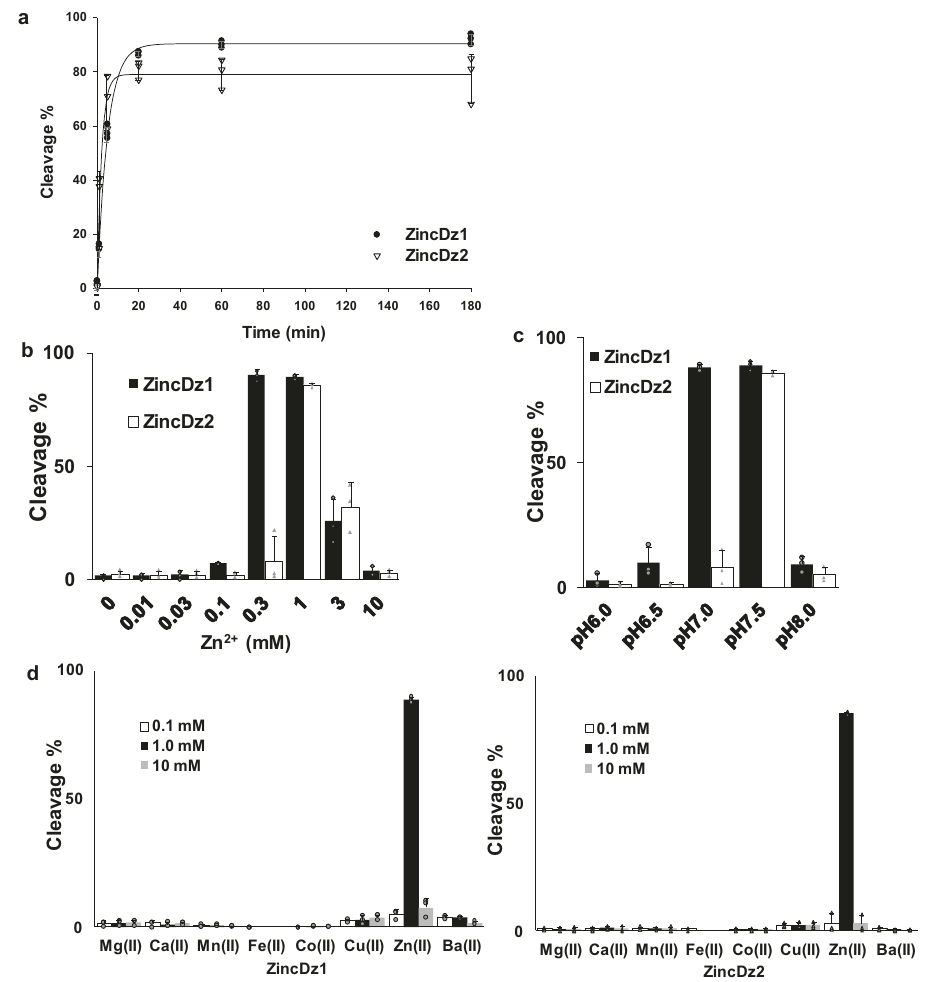
Fig. 2 Enzymatic properties of ZincDz1 and ZincDz2. a The cleavage kinetics of ZincDz1 and ZincDz2. The reaction was performed in buffer (50 mM HEPES, pH 7.5 and 150 mM NaCl) with 1 mM Zn 2 + at different time points (0, 5, 20, 60, and 180 min) under a single turnover condition (DNAzyme: Substrate = 10:1). b Zinc concentration dependencies and c pH pro fi les of ZincDz1 and ZincDz2. d The divalent metal ion selectivity (Mg 2 + , Ca 2 + , Mn 2 + , Fe 2 + , Co 2 + , Cu 2 + , Zn 2 + , and Ba 2 + ) of ZincDz1 (left) and ZincDz2 (right). The error bars represent the standard deviation (SD) from the average of three independent experiments at each point.